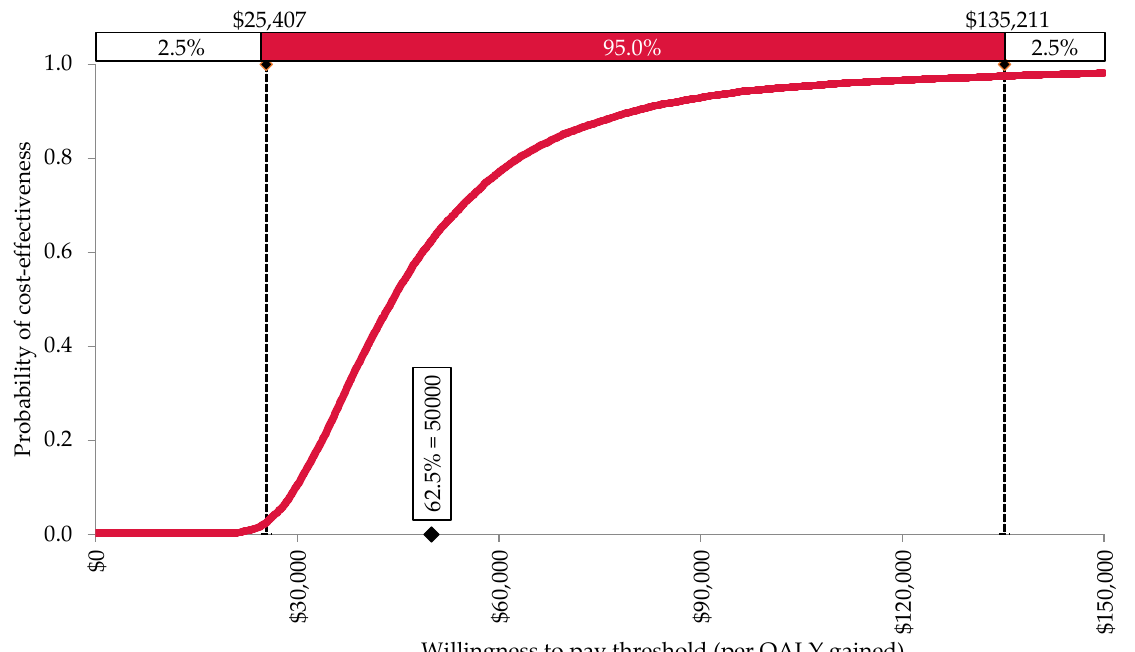
Figure 2. The cost-effectiveness acceptability curve, demonstrating that 62.5% of iterations were below Australia’s commonly-accepted willingness to pay threshold of AUD 50,000 per QALY gained. Results are reported in 2020 Australian dollars (AUD).